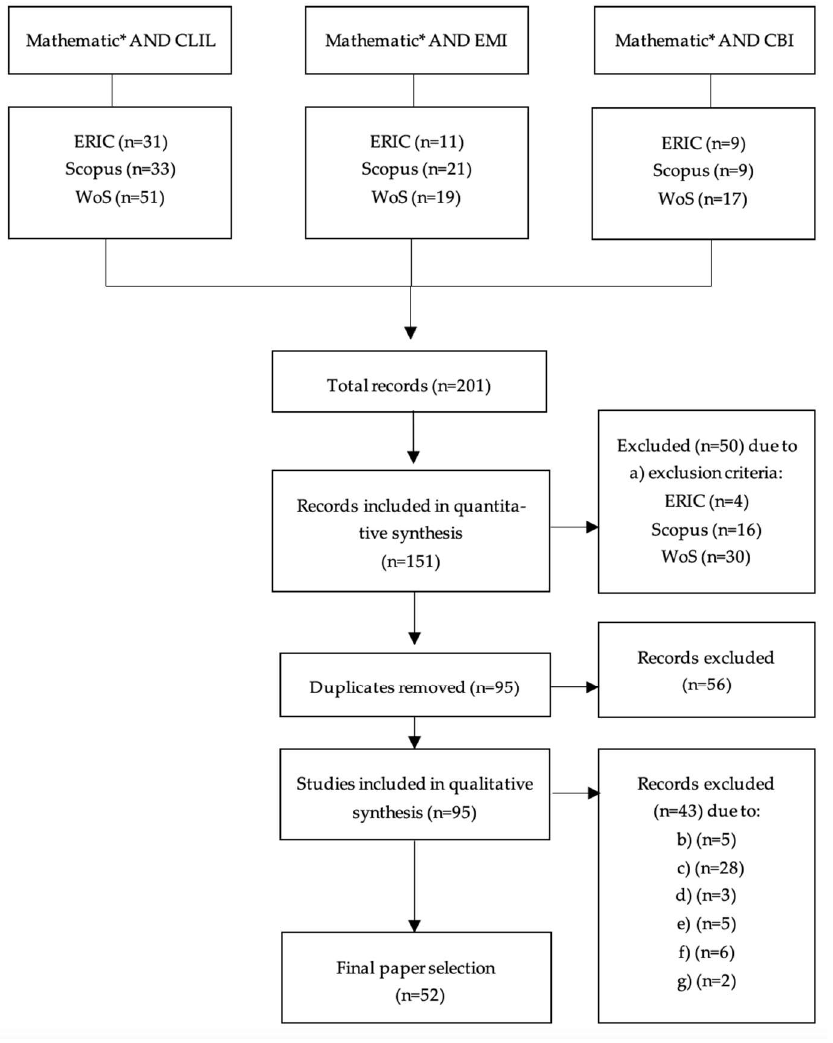
Figure 1. Flow diagram.